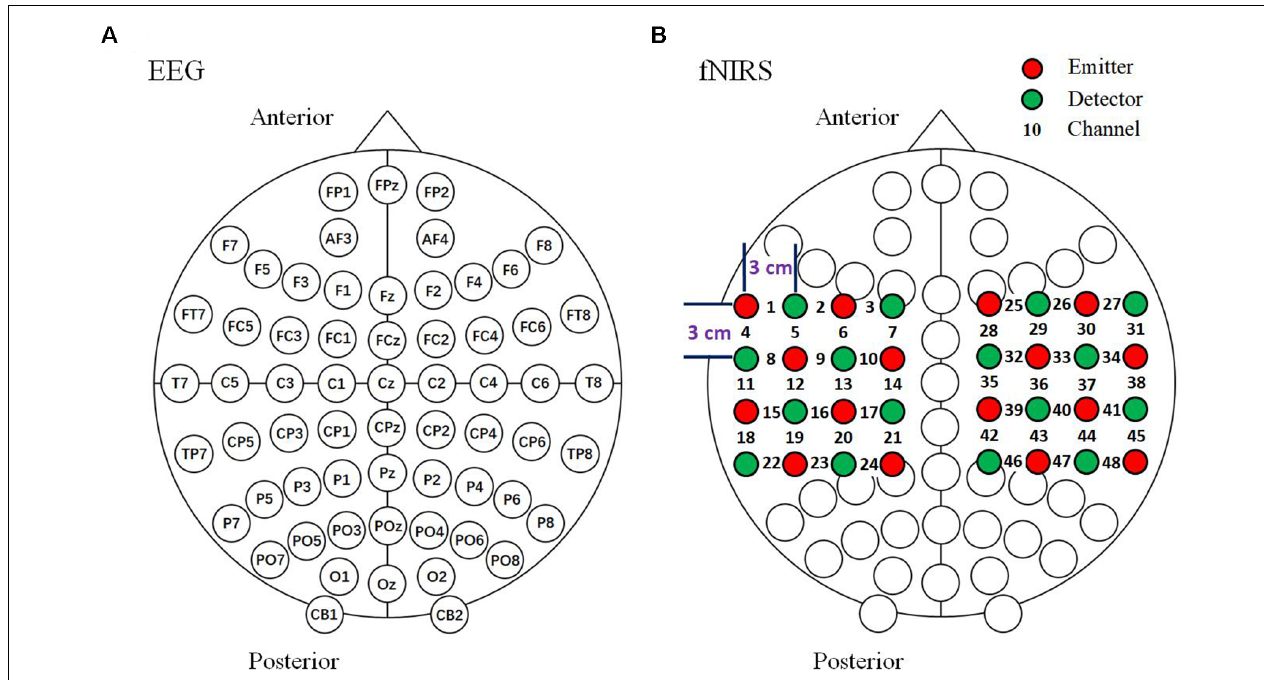
FIGURE 4 | Arrangement of EEG and fNIRS channels. (A) EEG 64-channel arrangement based on the international 10–20 system. (B) Optode arrangement for fNIRS. The optodes were arranged above the bilateral parietal areas. Sixteen emitters and 16 detectors in the arrangement resulted in a total of 48